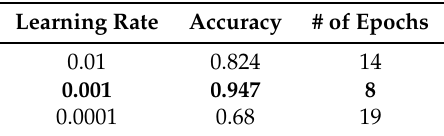
Table 4. Learning rate parameter variations. The best choice of parameters in terms of validation accuracy is highlighted in boldface font.